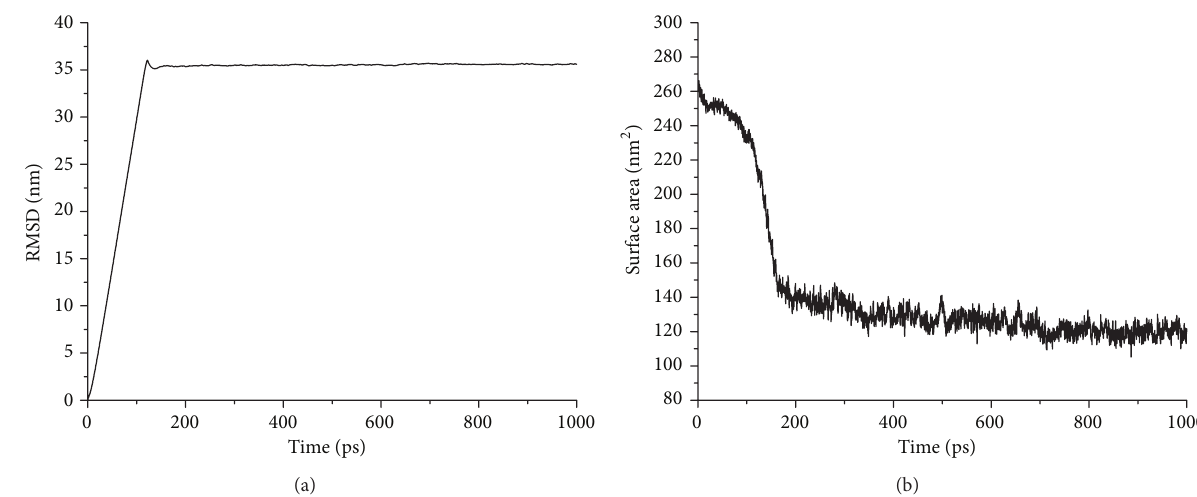
Figure 1: (a) The RMSD curve and (b) the surface area curve of the polyethylene chain during the 1ns CMD relaxation simulation.